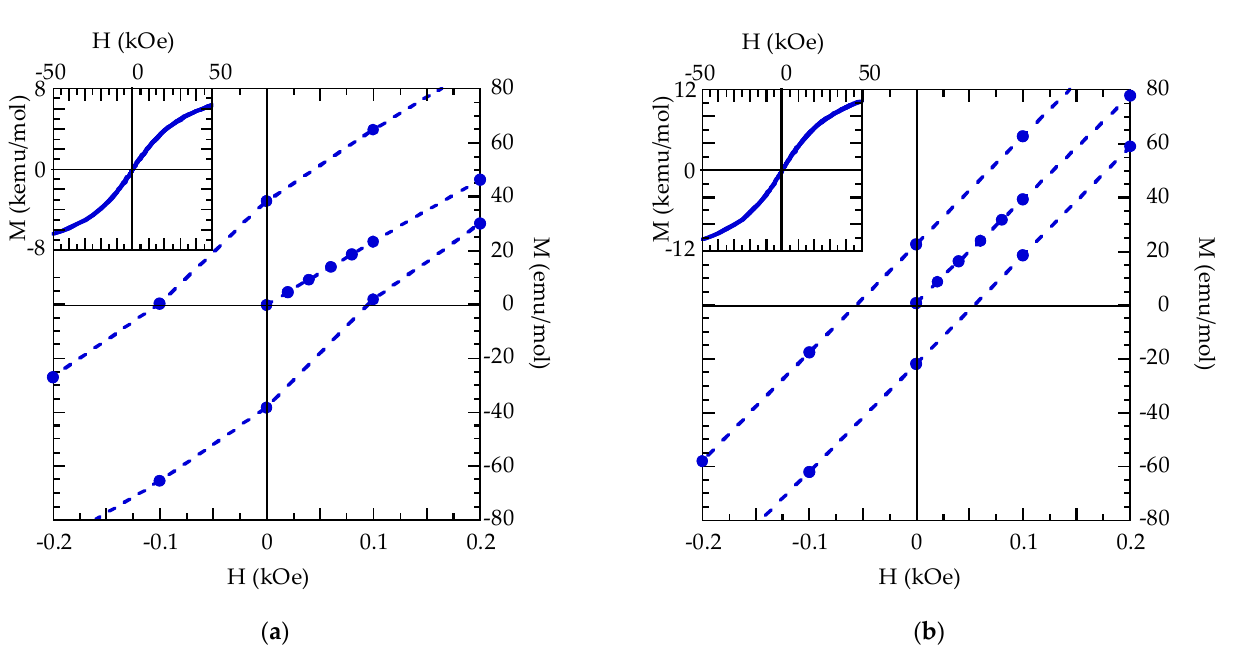
Figure 7. ( a ) Temperature dependence of the field-cooled magnetization recorded at H = 25 of Ho 0.5 Ca 0.5 MnO 3 nanoparticles (red points), calculated paramagnetic contribution of Ho 3+ (blue continuous line) and total paramagnetic contribution of Ho plus Mn species (green continuous line), both treated as free ions (see text). ( b ) Temperature dependence of the field-cooled magnetization and of its inverse (shown in Inset) after subtraction of the strong Ho 3+ paramagnetic contribution. The solid lines in Inset represent the linear fits in the high-temperature (HT) region (red) and in the low-temperature (LT) region (blue).